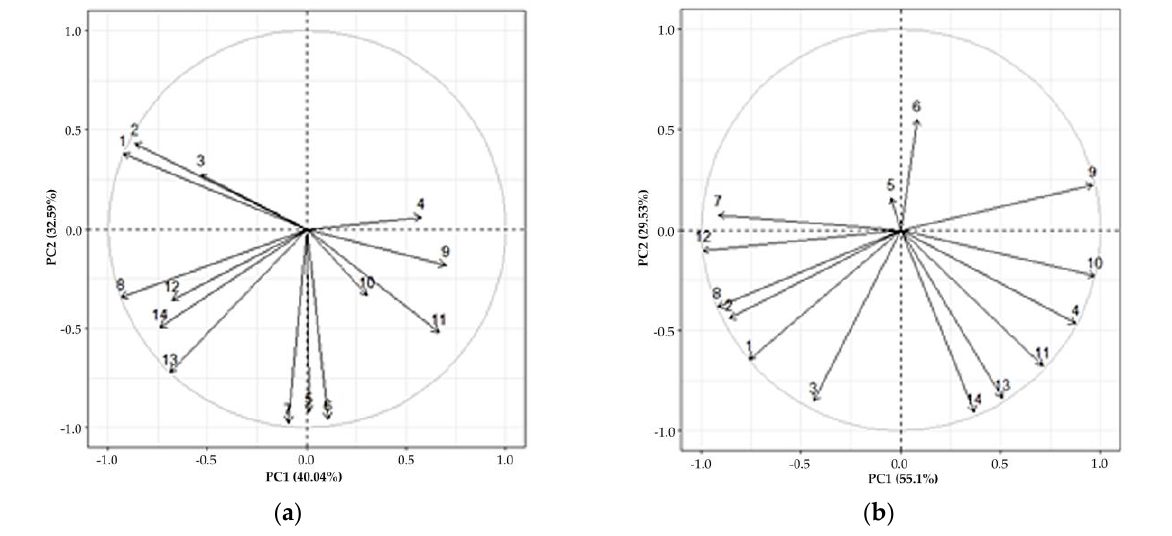
Figure 9. Influence of morphophysiological and anatomical parameters on correlations under salt